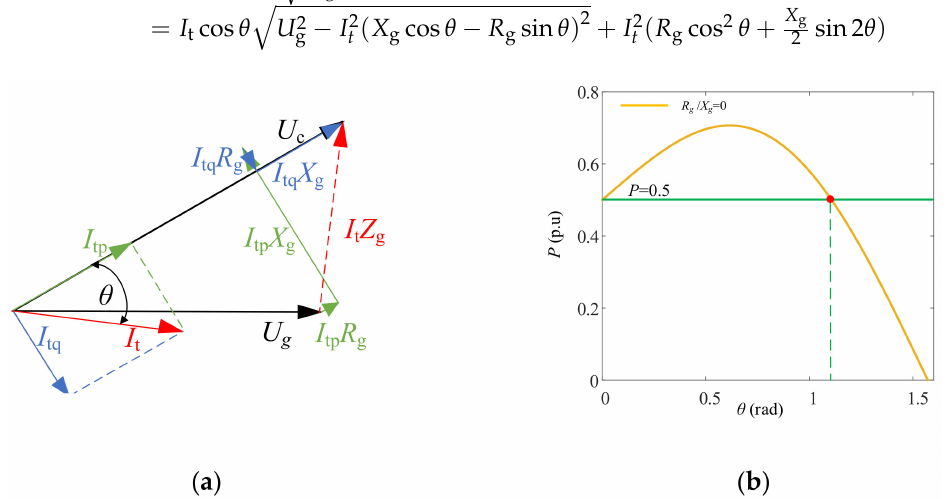
Figure 3. ( a ) Phasor diagram of the GFM converter provides the required reactive power; ( b ) plot of P and θ